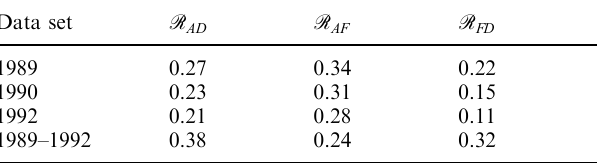
Table 1. Distances between temperature fields Data